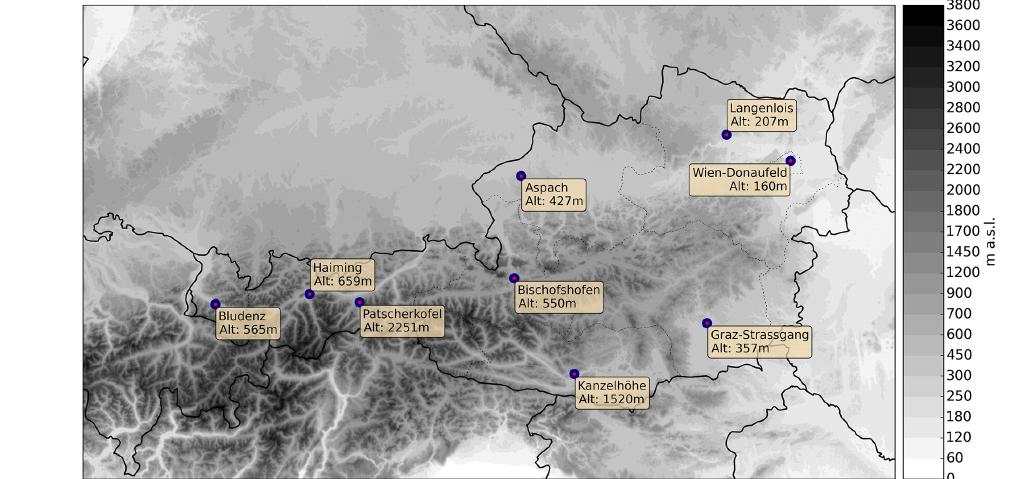
Figure 6. INCA domain and topography. Information on excluded TAWES stations for cross validation of SATIN analyses is included.